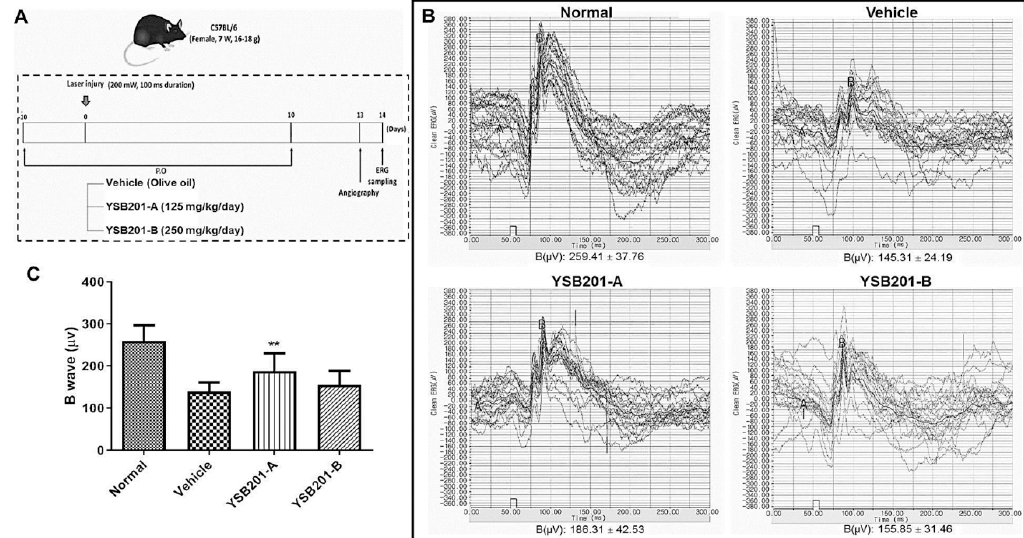
Figure 9. Measurement of the ERG response 14 days after CNV induction and oral administration of YSB201. ( A ) The diagram represents the experimental scheme with CNV model establishment and drug administration schedule. ( B ) As of the representative dark-adapted ERG response, A and B wave amplitudes are shown for the normal mice and treatment group with the vehicle or YSB201-treated group (YSB201-A (125 mg/kg), YSB201-B (250 mg/kg)). ( C ) The B-wave amplitudes of ERG data in the YSB201-A (125 mg/kg) or YSB201-B (250 mg/kg)-treated group are shown with the data in the normal or the vehicle-treated group. * p < 0.05, ** p < 0.01, *** p < 0.001, by 1-way ANOVA test (significance level = 0.05).